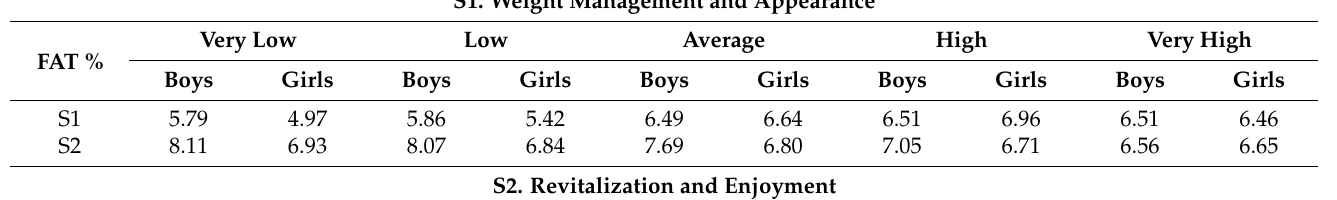
Table 4. S1 (Weight Management and Appearance) and S2 (Revitalization and Enjoyment) sub- scales scored by FAT % and BMI.